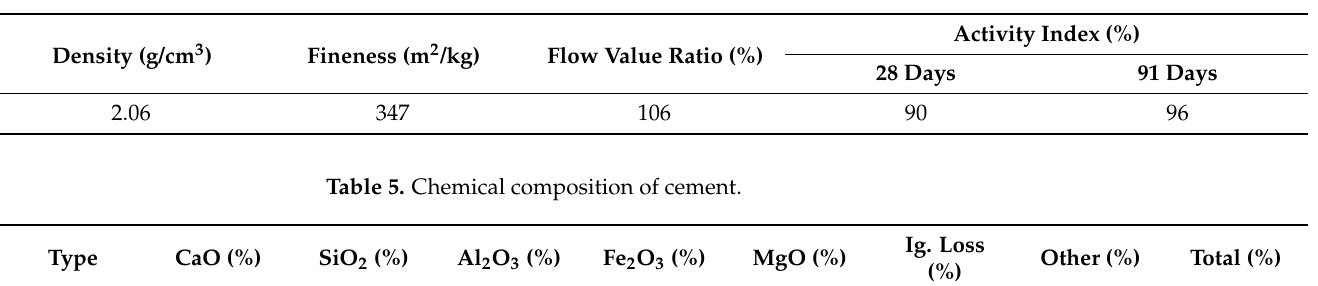
Table 3. Physical properties of cement.